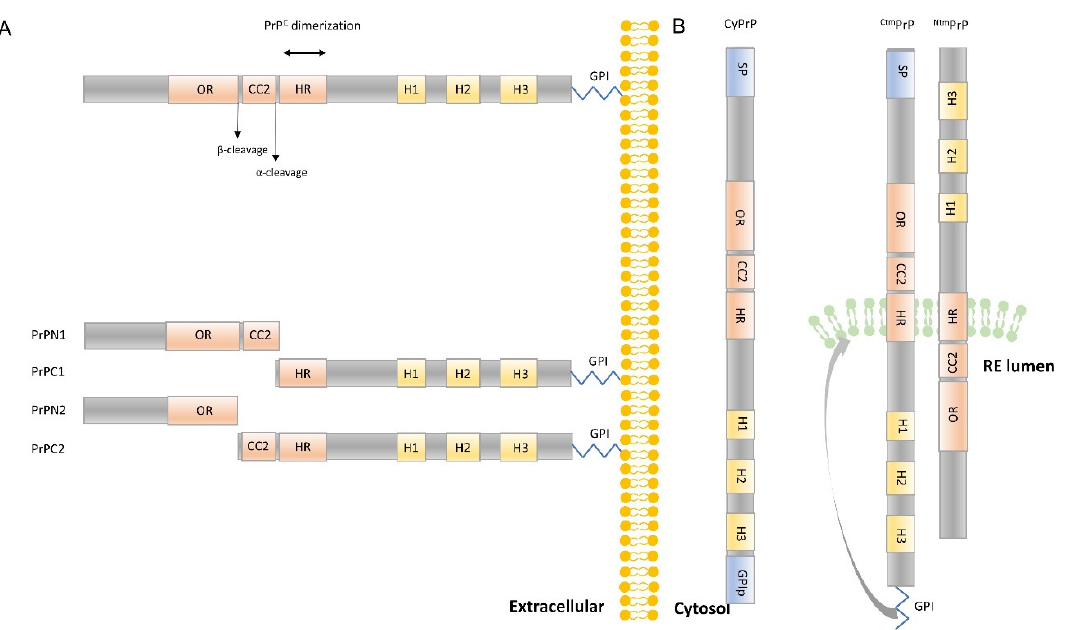
Figure 3. Schematic representation of PrP C isoforms: ( A ) Cell surface PrP C and the four metabolites resulting from α - and β -cleavage (PrPN1, PrPC1, PrPN2, PrPC2, respectively). Homodimerization of PrP C enhanced α -cleavage and consequently the production of anti- β activity of PrPN1. ( B ) Cytosolic PrP (CyPrP) and the two transmembrane isoforms termed Ntm PrP and Ctm PrP with opposite sequence orientations with respect to the lumen of the endoplasmic reticulum. As the CC1 domain is not involved in the generation of different PrP C isoforms, it has not been included in this figure.